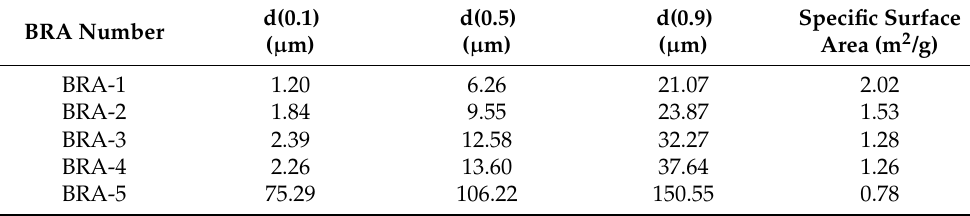
Table 2. Particle-size testing results of BRA.